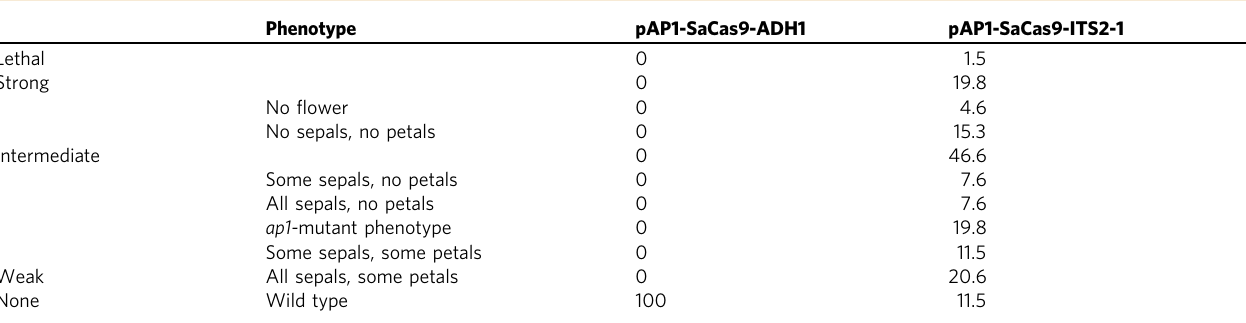
Fig. 3 CRISPR-Kill-mediated fl oral tissue elimination by cleaving 45S rDNA repeats in Arabidopsis . a The fl oral homeotic protein, APETALA1 (AP1), is highly expressed in the early fl oral meristem at fl ower development stages 1 and 2 (red). At development stage 3, the expression is restricted to speci fi c tissue, which is determined to form sepals and petals. b Schematic representation of the ap1 mutant phenotype: a disturbed fl ower architecture with an extra set of carpel and stamen instead of sepals and petals. c A comparison of survival rates between the T1 control line (pAP1-SaCas9-ADH1) and the T1 fl ower-speci fi c CRISPR-Kill line (pAP1-SaCas9-ITS2-1) revealed no signi fi cant differences ( n = 3 biologically independent experiments). Data are presented as normalized mean values± SD. Statistical differences were calculated using the two-tailed t -test with unequal variances. d Representative fl oral phenotypes of pAP1-SaCas9-ADH1 control line and pAP1-SaCas9-ITS2-1 CRISPR-Kill line. Bar = 1 mm. Statistical differences were calculated using the two- tailed t -test with unequal variances. Source data are provided as a Source data fi le. Table 1 T1 phenotypes of CRISPR-Kill-mediated fl oral tissue elimination by cleaving 45S rDNA